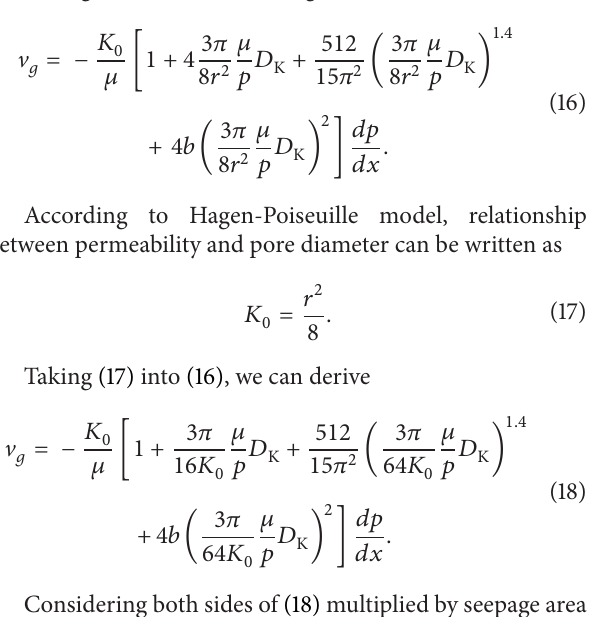
Table 2: Conformal transformations of the fractured